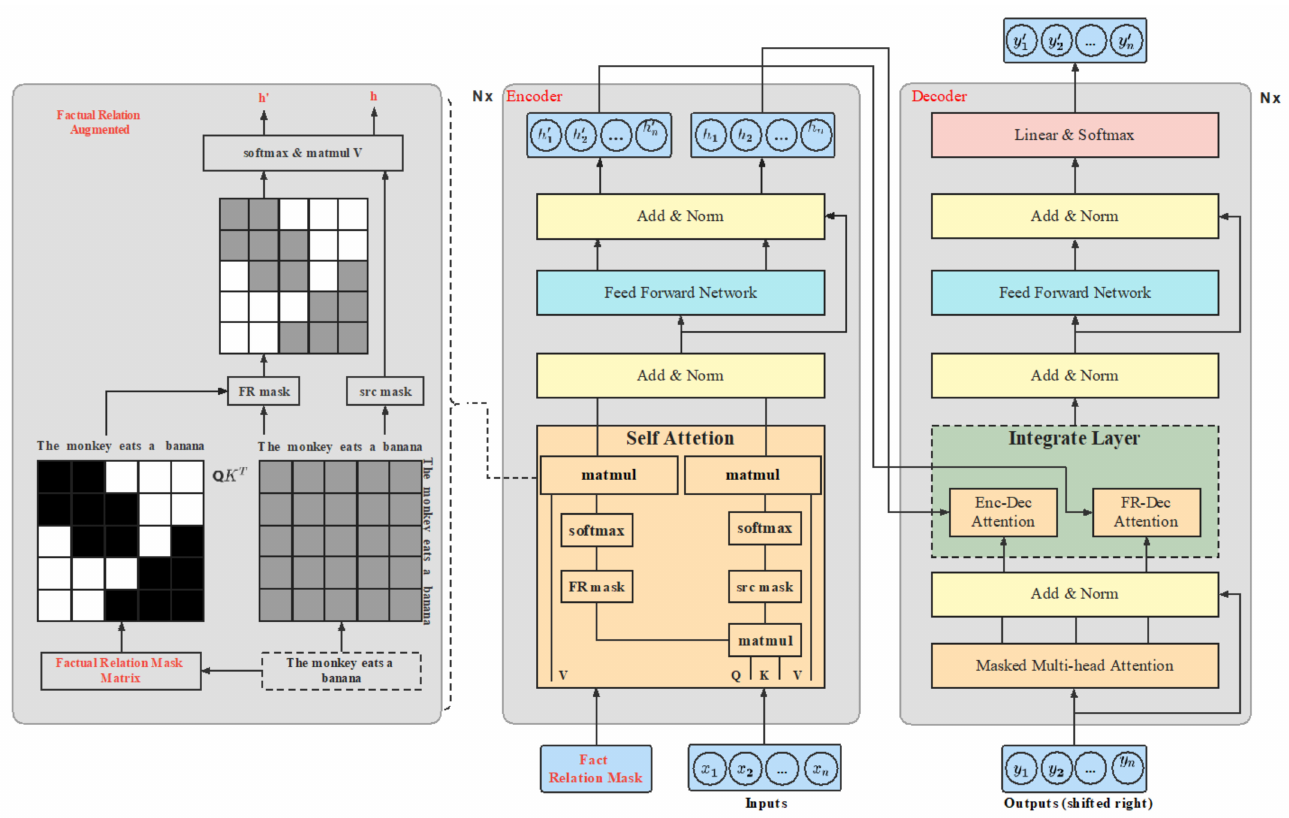
Figure 2. The architecture of the Factual Relation Augmented